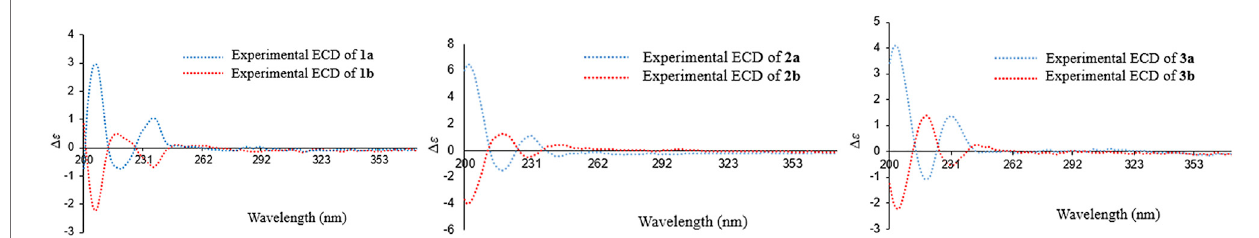
FIGURE 3 | Experimental ECD curves of compounds 1 – 3.